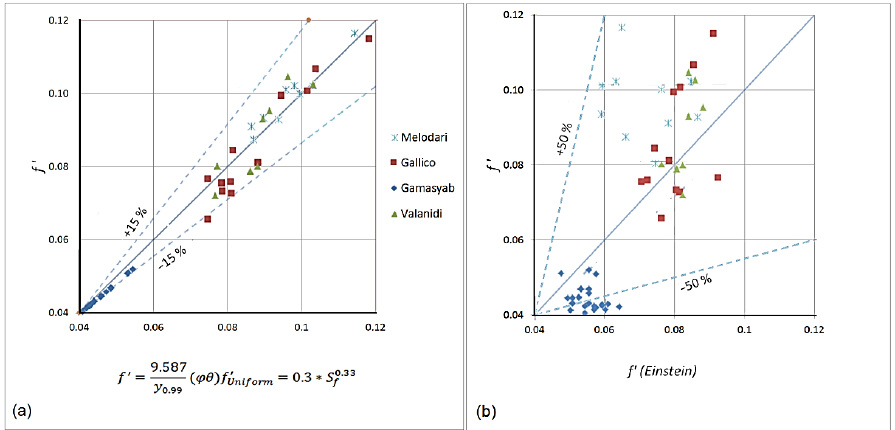
Figure 11. Comparison between the values of skin friction factor calculated via BLCM and Equation (21) ( a ) and Einstein equation ( b ).